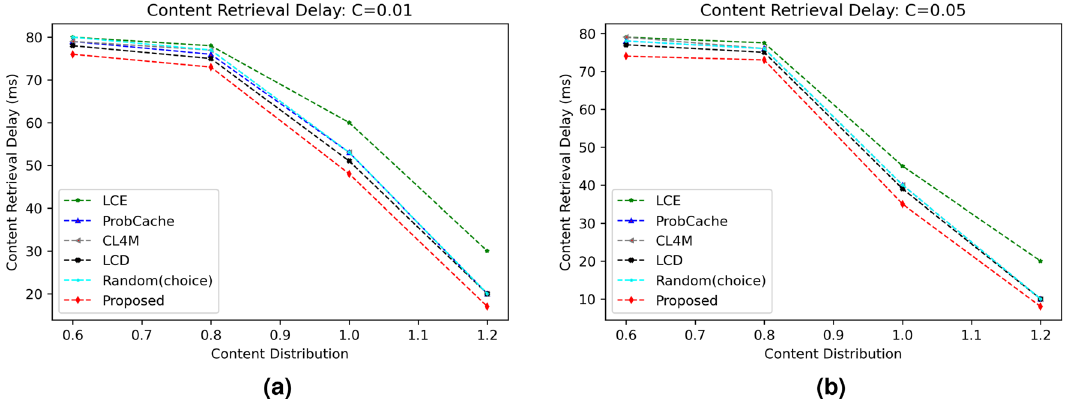
Figure 5. Influence of content distribution (α) on CRD.